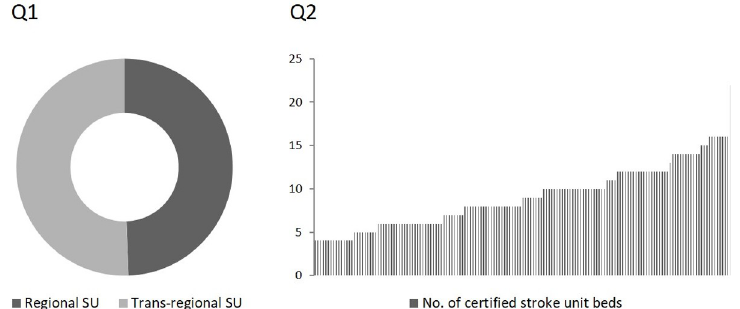
Fig 1. Question (Q) 1 : Please indicate if our stroke unit is a regional or a trans-regional stroke unit (SU).